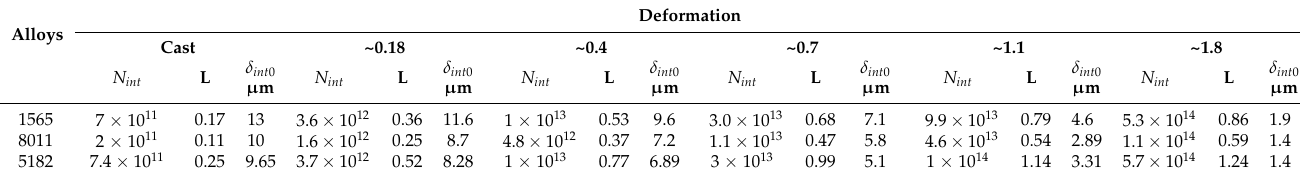
Table 5. Parameters of size distribution of intermetallic particles.